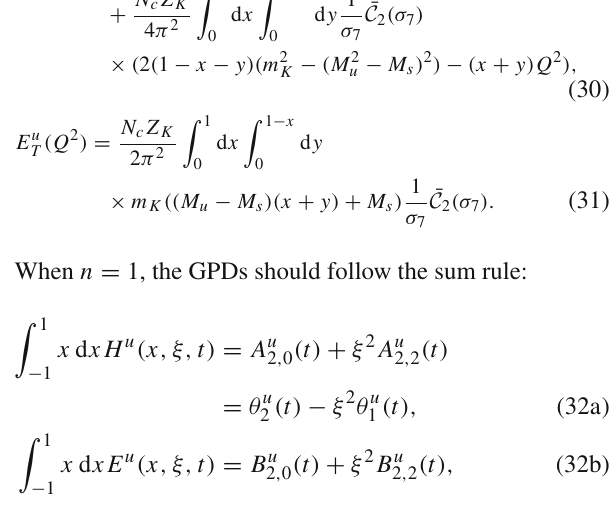
anomalous magnetic moment B u